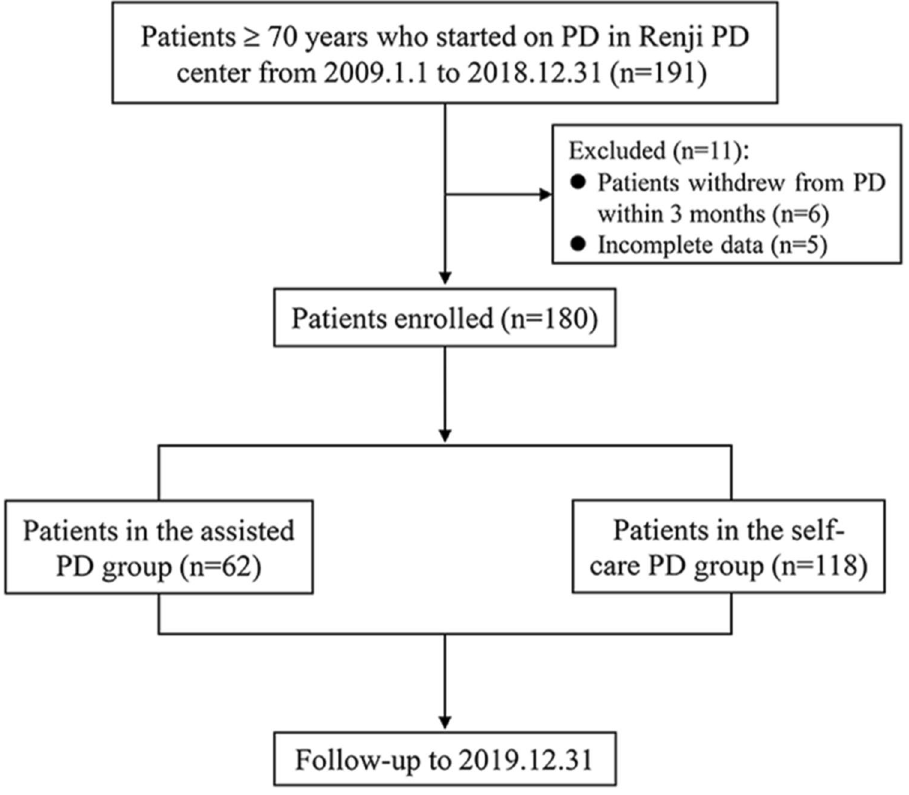
Figure 1. Patient enrollment and follow-up. Abbreviations: PD peritoneal dialysis, HD